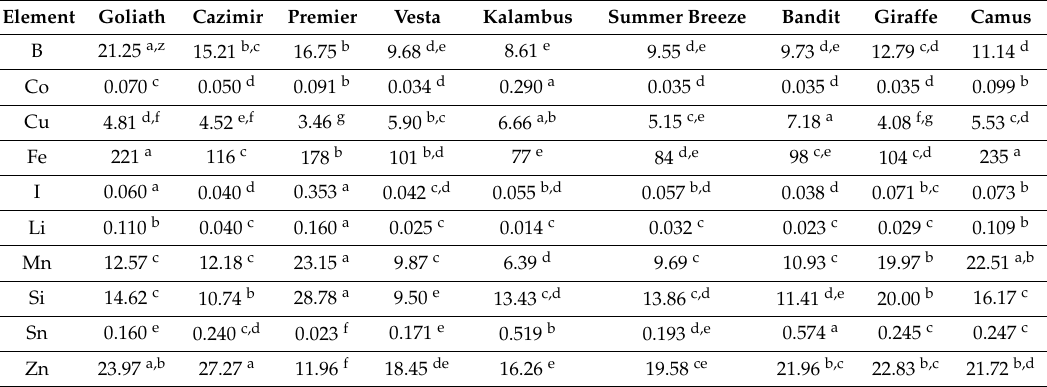
Table 4. Microelements concentration in A. porrum pseudo-stems (mg/kg d.w.). Element